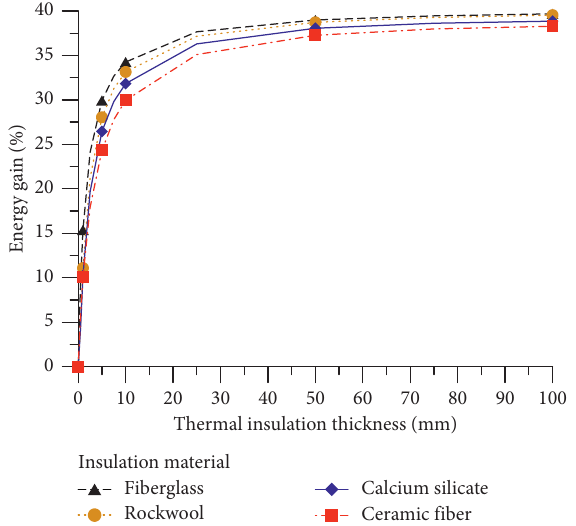
Figure 16: Energy gain as a function of the thermal insulation thickness.